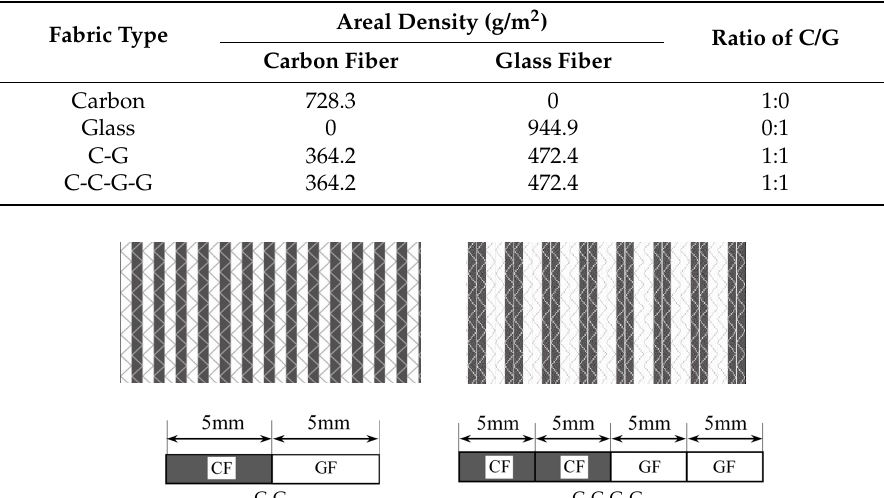
Table 1. Hybrid fabric specifications.